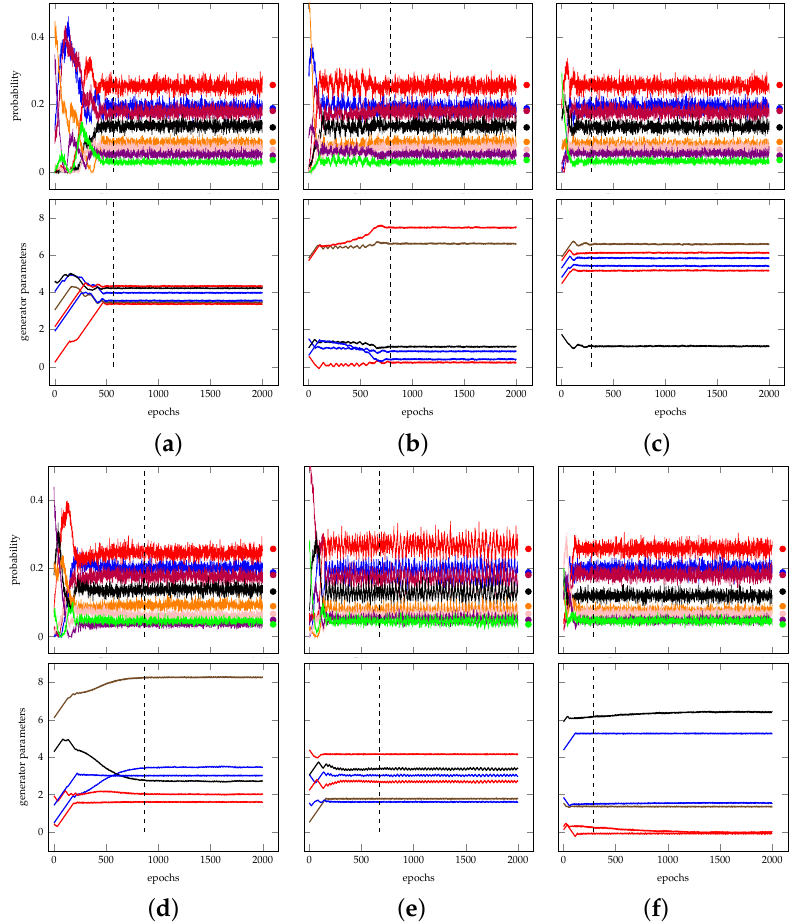
Figure A14. Focus on experiments ( H 1 , H 2 ) = ( 64,8 ) from test set B. In each couple of plots, the one above represents the evolution of the trained PDF, while the one below contains the evolution of parameters, as in Figure 3. ( a – c ) The optimal runs. ( d – f ) Examples of sub-optimal runs. Vertical dashed lines mark the convergence epoch, as detected by our rule (refer to Section 5.2). ( a ) An optimal case, with an elbow in the parameters at convergence time. ( b ) Another optimal case, with similar behavior. ( c ) The third optimal run, with a less characterized behavior. ( d ) A sub-optimal run characterized by slow convergence. ( e ) A sub-optimal run characterized by oscillations. ( f ) A sub-optimal run with non-steady parameters after